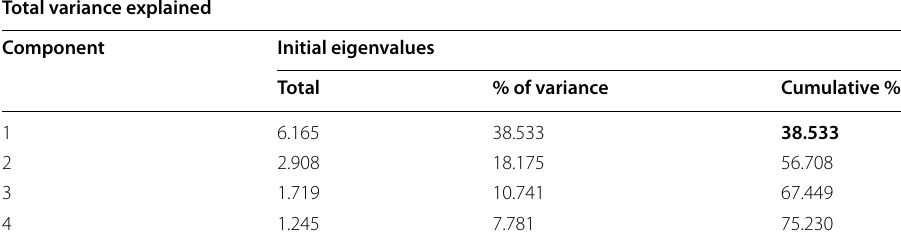
Table 2 The highest components of PCA for the second runs Total variance explained Component Initial eigenvalues Total % of